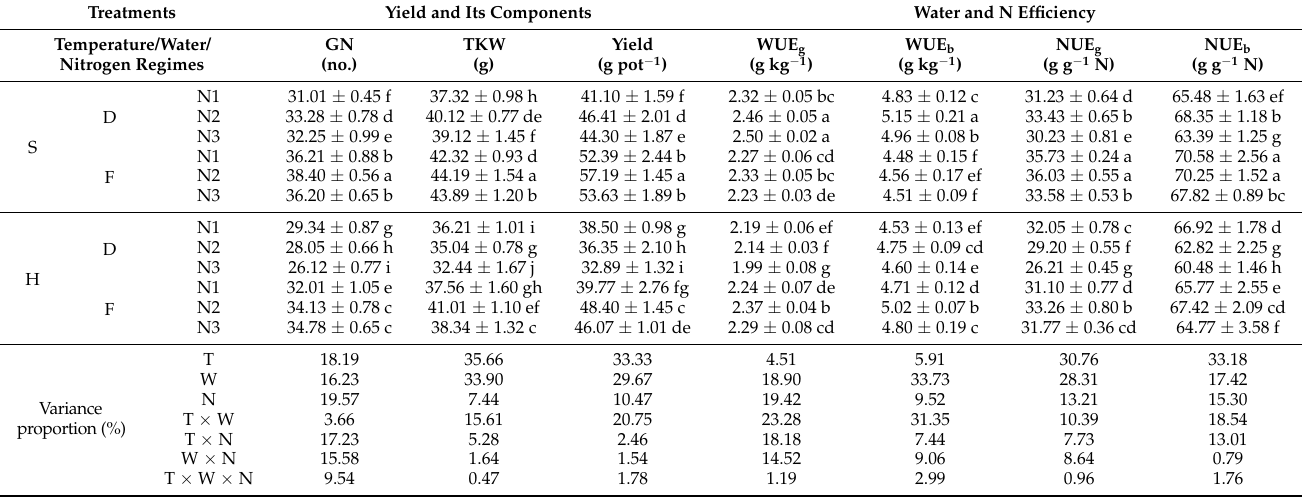
Table 2. Effects of N application on yield, yield components, water and N use efficiency of wheat plants under short-term heat, drought and combined stress after